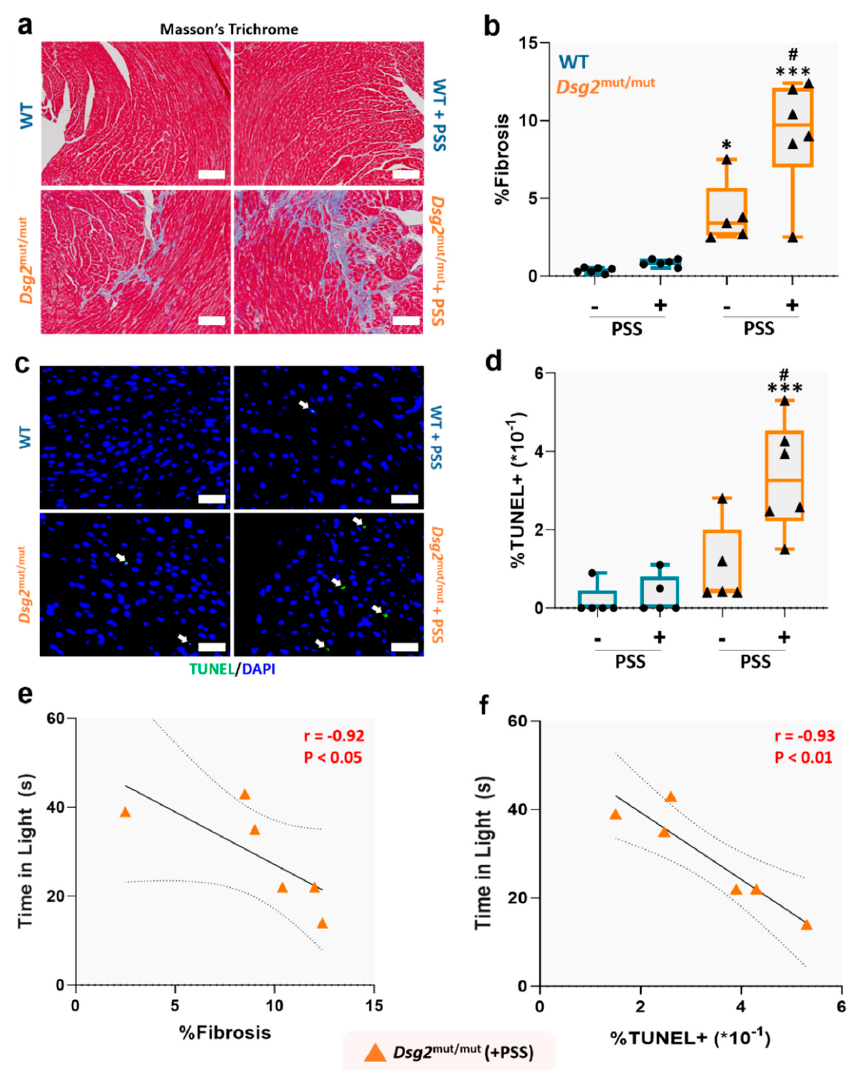
Figure 6. Psychosocial stress worsens pathological progression in Dsg2 mut / mut mice. ( a ) Representative images of Masson’s Trichrome immunostained myocardium. White scale bars, 100 µ m. Images are representative of n = 5–6 mice / cohort; ( b ) Percent (%) myocardial fibrosis; ( c ) Representative images of myocardium immunostained for TUNEL and DAPI. Images are representative of n = 5–6 mice / cohort. White arrows, TUNEL positive ( + ) nuclei; white scale bars, 25 µ m. ( d ) Percent (%) TUNEL + nuclei in 5 microscopic fields from each mouse / cohort. For ( b , c ) data presented as box-whisker plots, n = 5–6 mice / cohort. PSS, psychosocial stress. * p < 0.05, *** p < 0.001 vs. WT ( + PSS) and WT ( − PSS); # p < 0.01 Dsg2 mut / mut ( + PSS) vs. Dsg2 mut / mut ( − PSS); using One-Way ANOVA and Tukey’s post-hoc analysis. For ( b , d ), black dots are WT mice (with or without PSS) and black triangles are Dsg2 mut / mut mice (with or without PSS). ( e , f ) Anxiety levels induced by PSS correlates with cardiac remodeling in Dsg2 mut / mut mice. Correlation between time spent in light and ( e ) percent (%) fibrosis and ( f ) percent (%) TUNEL + nuclei in Dsg2 mut / mut ( + PSS) mice. Data displayed as scatterplots; thick black lines show the best linear fit through data; dotted lines represent two-tailed 95% confidence interval; text inset reports Spearman’s Rho values and associated p